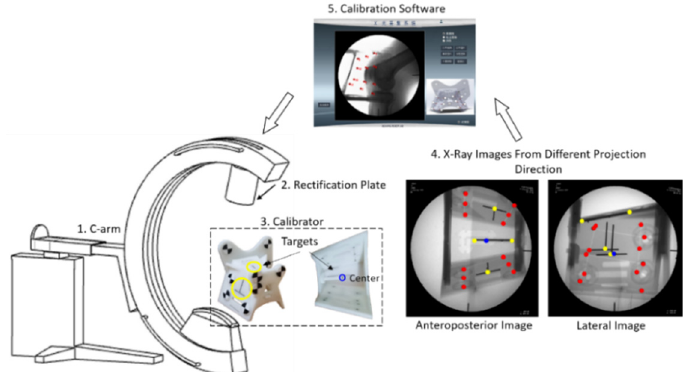
Figure 12. Structure of C-arm calibration experiment: the target at the center of the calibrator was marked in blue; other targets on the surface of the calibrator were marked in yellow; fiducial points were marked in red.